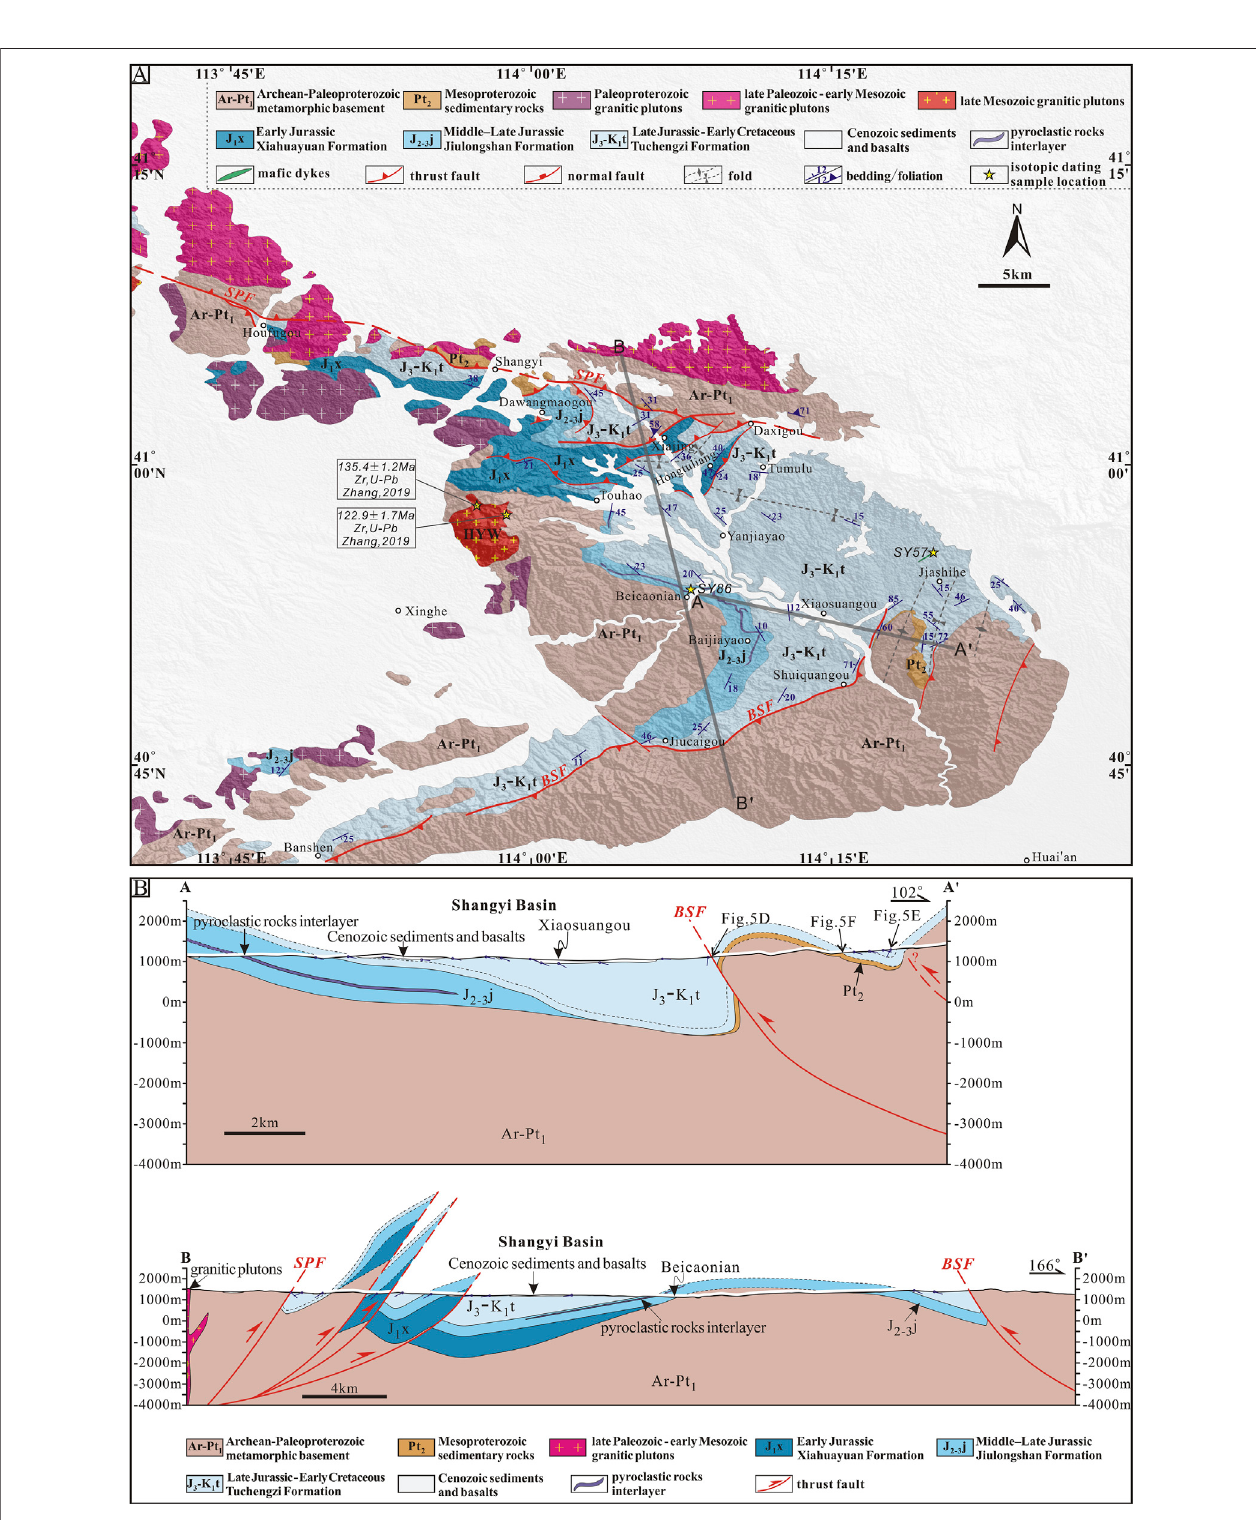
FIGURE2|(A) GeologicmapofShangyiarea(modi fi edafterXuetal.,2016). (B) CrosssectionsofA-A ’ andB-B ’ . See Figure1B forlocationofthismap.Locations of geochronological samples are shown on the map, and locations of some photos ( Figures 5D – F ) are also shown on the section A-A ’ . HYW, Huangyuwa granitic pluton. The rest fi gure captions are the same as Figure 1B .